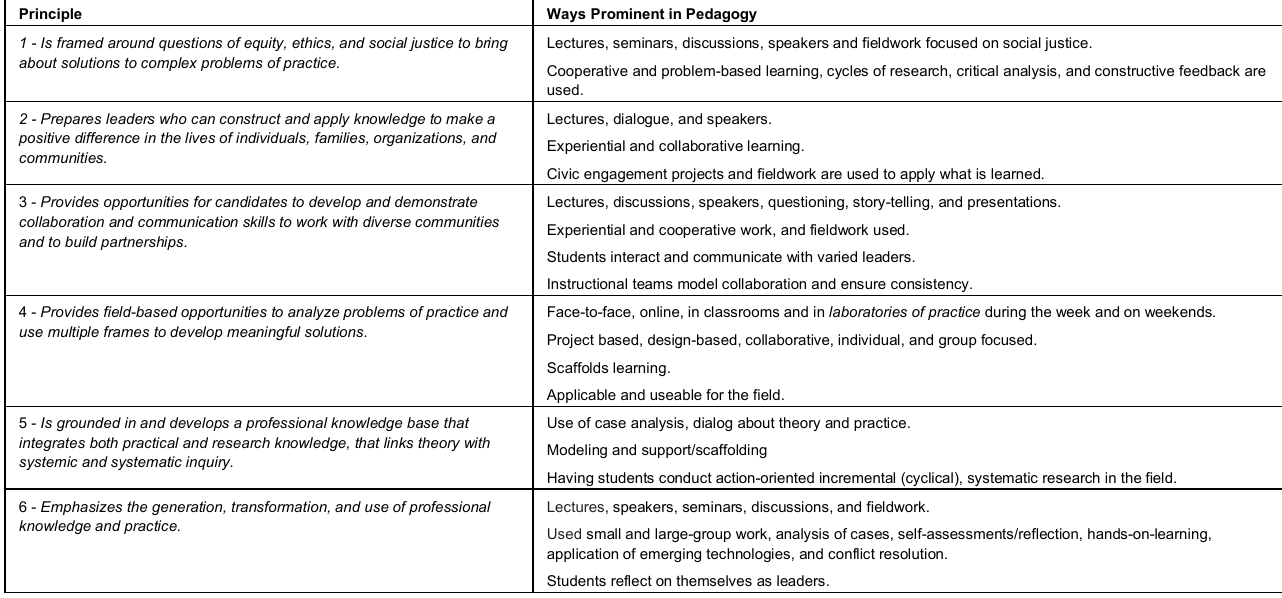
Table 2. The Principles in Pedagogy Principle Ways Prominent in Pedagogy